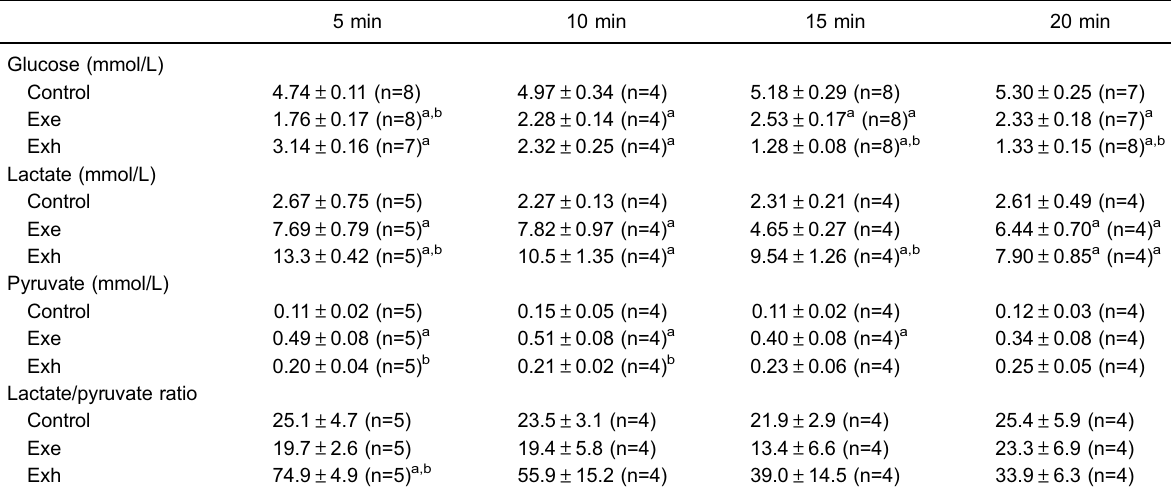
Table 1. Blood levels of glucose, lactate, pyruvate, and lactate/pyruvate ratio in 15 h fasted rats submitted to swimming and that reached exhaustion in 5, 10, 15, and 20 min.